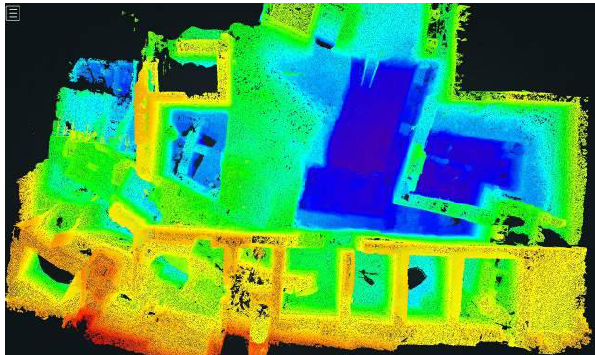
Figure 10: Potree Online Wiewer, Givati Parking Lot Excavation 3D Model, Elevation